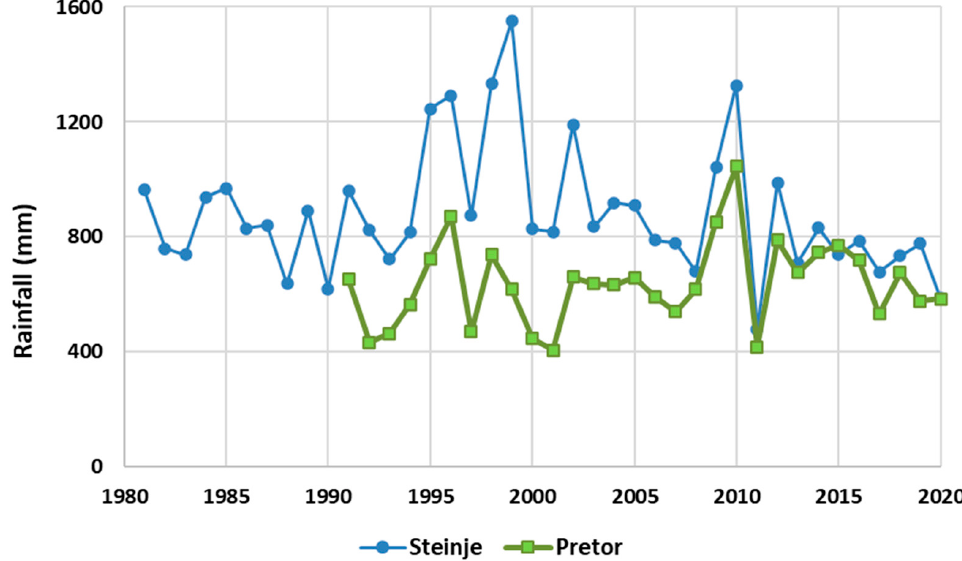
Figure 3. Values of annual rainfall from 1981 to 2020 in Stenje and Pretor stations, on the shore of Prespa Lake. Source data: National Hydrometeorological Service of North Macedonia.